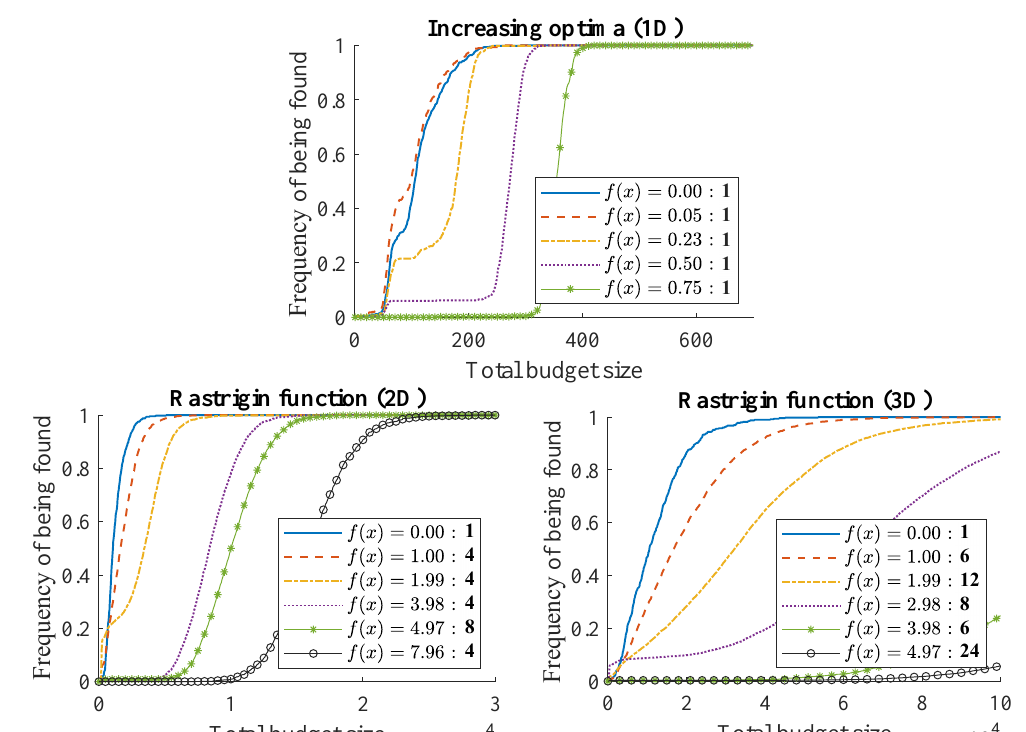
Figure 8. The frequencies of local optima of different qualities being found as the total budget size increases. The number in bold shows the number of optima having this objective function value. A total of 500 replications are